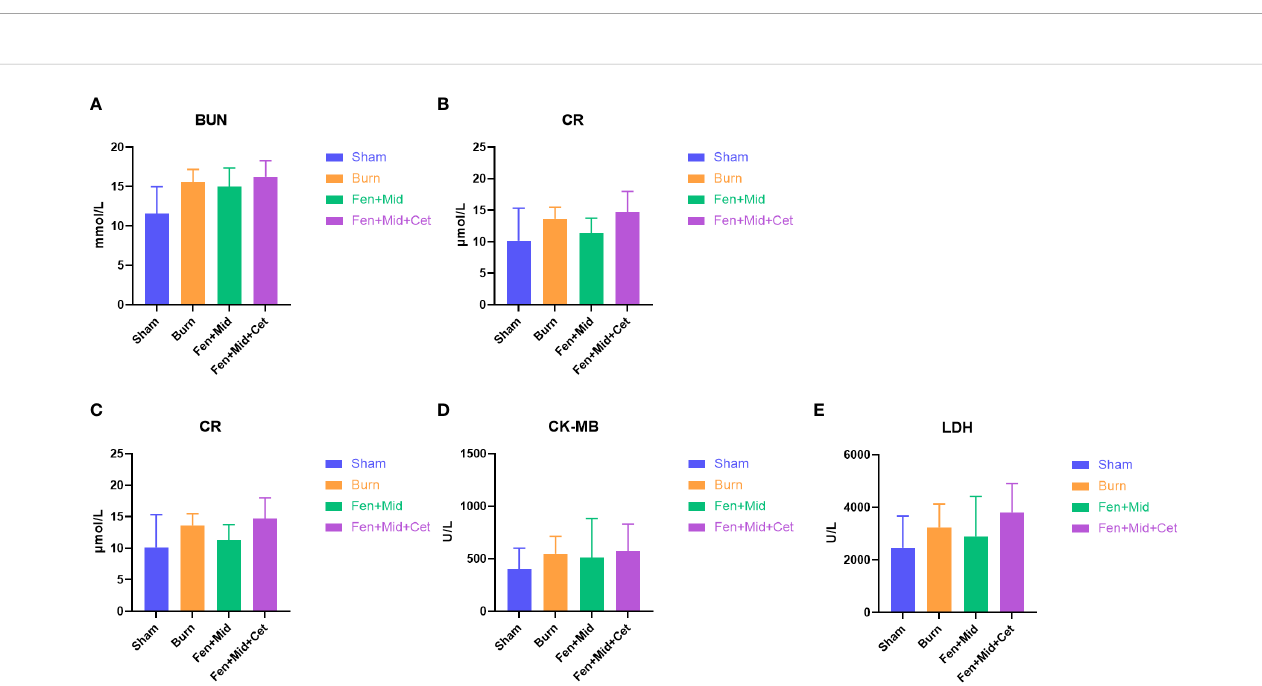
FIGURE 5 Effects of fentanyl and midazolam combined with cetirizine on heart and kidney injury in rats after severe burns. The plasma blood urea nitrogen (BUN, (A) ), creatinine (CR, (B) ) creatine kinase (CK, (C) ), creatine kinase isoenzyme MB (CK-MB, (D) ), and lactate dehydrogenase (LDH, (E) ) levels of rats in large area scald group (Burn), sham scald group (Sham), fentanyl + midazolam group (Fen+Mid), or fentanyl + midazolam + cetirizine group (Fen+Mid+Cet) were measured. n =